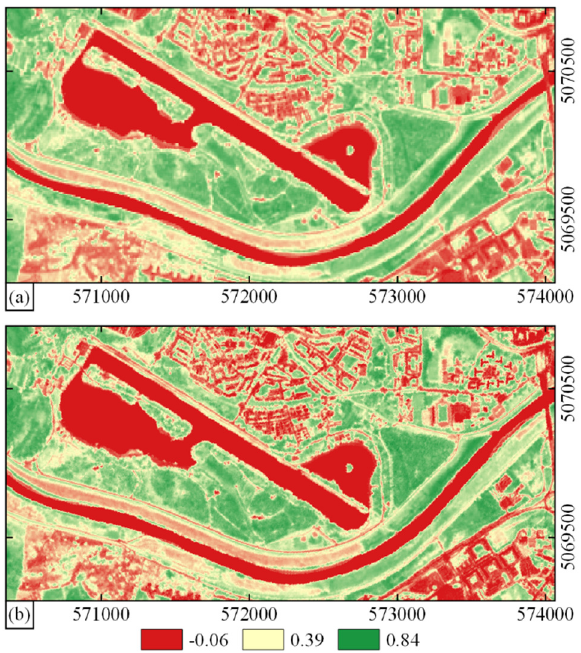
Figure 7. NDVI value of the example subset based on the: (a) S- 2 and (b) fused